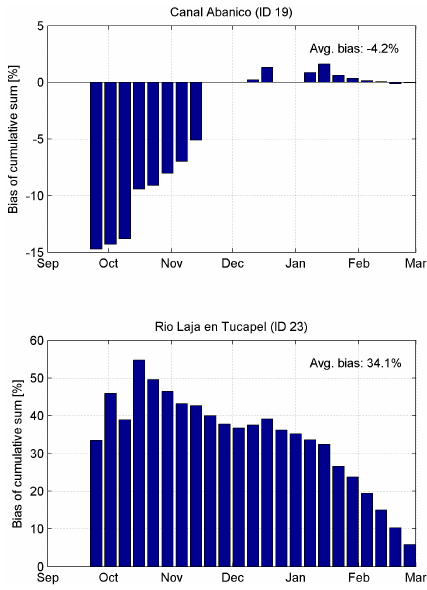
Figure 12. Bias between total cumulative forecasted flow and ob- served flow for the 23 model runs that were executed between the end of September 2013 and March 2014. Results are shown for the locations Canal Abanico (ID 19) and Rio Laja en Tucapel (ID